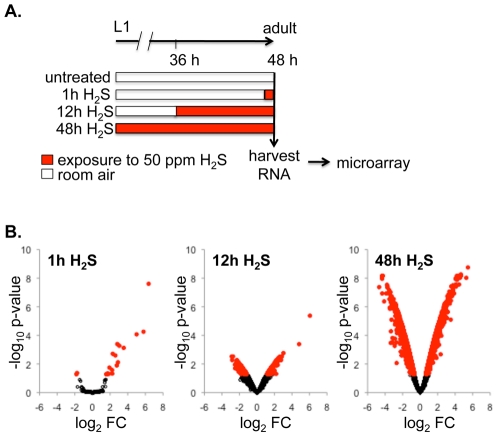
Exposure to H2S induces rapid and progressive changes in mRNA abundance.A. Experimental design schematic. C. elegans were grown from synchronized first-stage larvae (L1) for 48 h to young adult before being collected for RNA extraction. Each bar represents 48 h from L1 to first-day adult for one experimental group. Time in room air is indicated in white and time in H2S indicated in red. Exposure to H2S (50 ppm in room air) was always immediately prior to isolating RNA. B. Changes in mRNA abundance measured by microarray. Plots show magnitude of change in transcript level (log2 FC) as a function of adjusted p-value (log10 p-value). Each point is data from one gene product. Significant changes (adj. p-value<0.05) are red. After 1 h exposure to H2S (left), 16 genes were significantly up-regulated and one was down-regulated (Table 1). After 12 h exposure to H2S (middle), 445 transcripts were significantly changed, with 259 up-regulated (Tables 1 and S1). After 48 h in H2S (right), 5089 transcripts were significantly altered relative to untreated controls (Table S2).